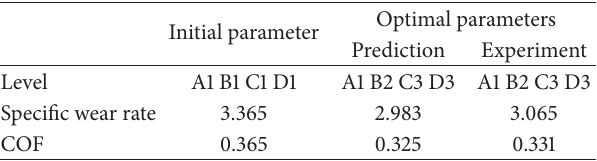
Table 5: Confirmation